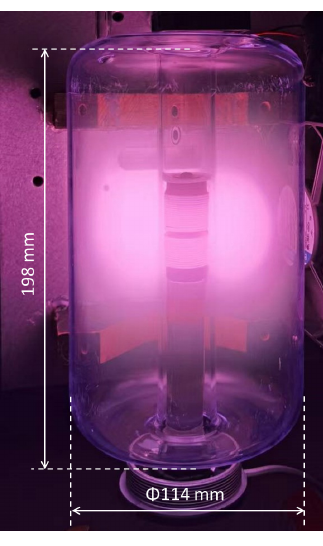
Figure 6. Photograph of Ar/H 2 ICP (with 35% H 2 , at pressure of 5 Pa and power of 165 W).